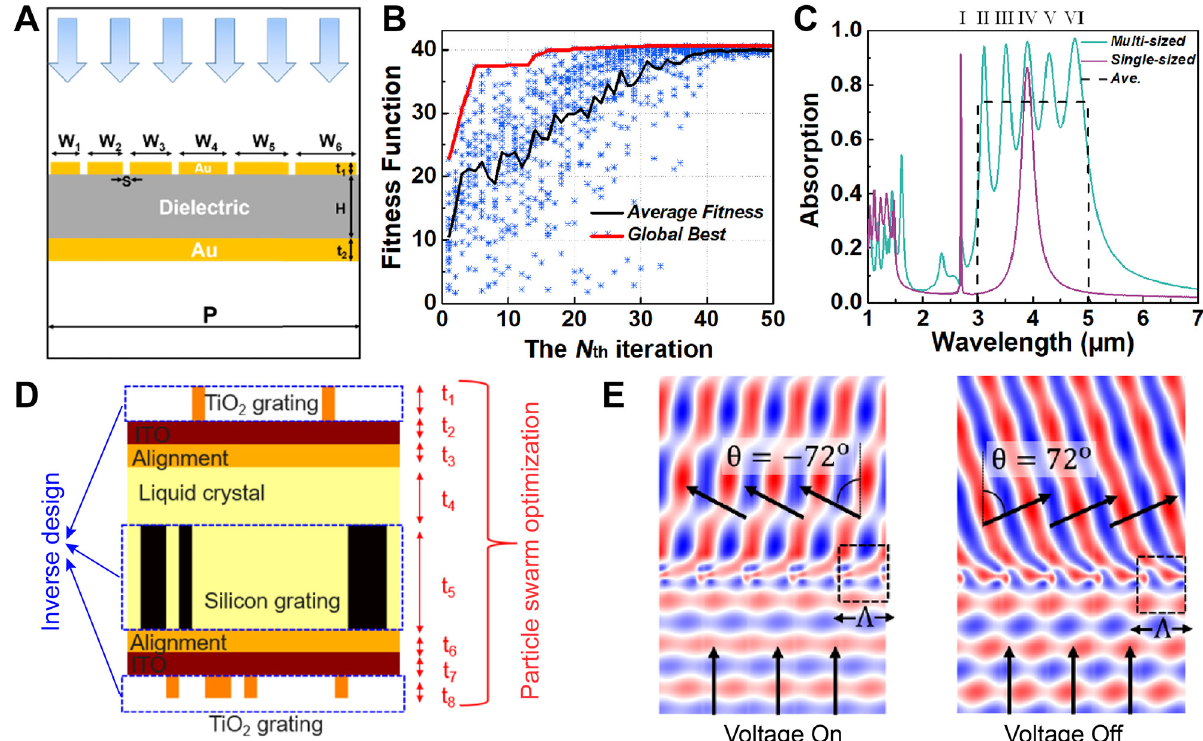
Figure 6: Nanophotonic device optimization using PSO and its results. ( A )Schematicofthree-layerPMAstructure.( B )FitnessfunctionevolutionthroughPSOprogress.Theblacklineindicatesaverage fi tnessvalue ateachiteration.Theredlineindicatesthelargest fi tnessvalueobservedsincethe fi rstiteration.Thebluestarsrepresentthe fi tnessvaluesof all particles at each iteration. ( C ) TM-wave absorption spectra for the multi-sized nanostrips (green line) and the single-sized nanostrip absorber (purple line). Mark I to VI corresponds to the LSPR peaks induced by individual nanostrip in multi-sized nanostrip absorber. The average absorption of 73.7% for the multi-sized nanostrip absorber is indicated as black dashed line. A – C Figures are adapted with permission from [77]. Copyright 2019, Optical Society of America. ( D ) Schematic of liquid crystal-based electrically tunable beam switching metasurface. ( E ) Real parts of the electric fi elds plot for the voltage-on (left) and voltage-off (right) states. D, E adapted with permission